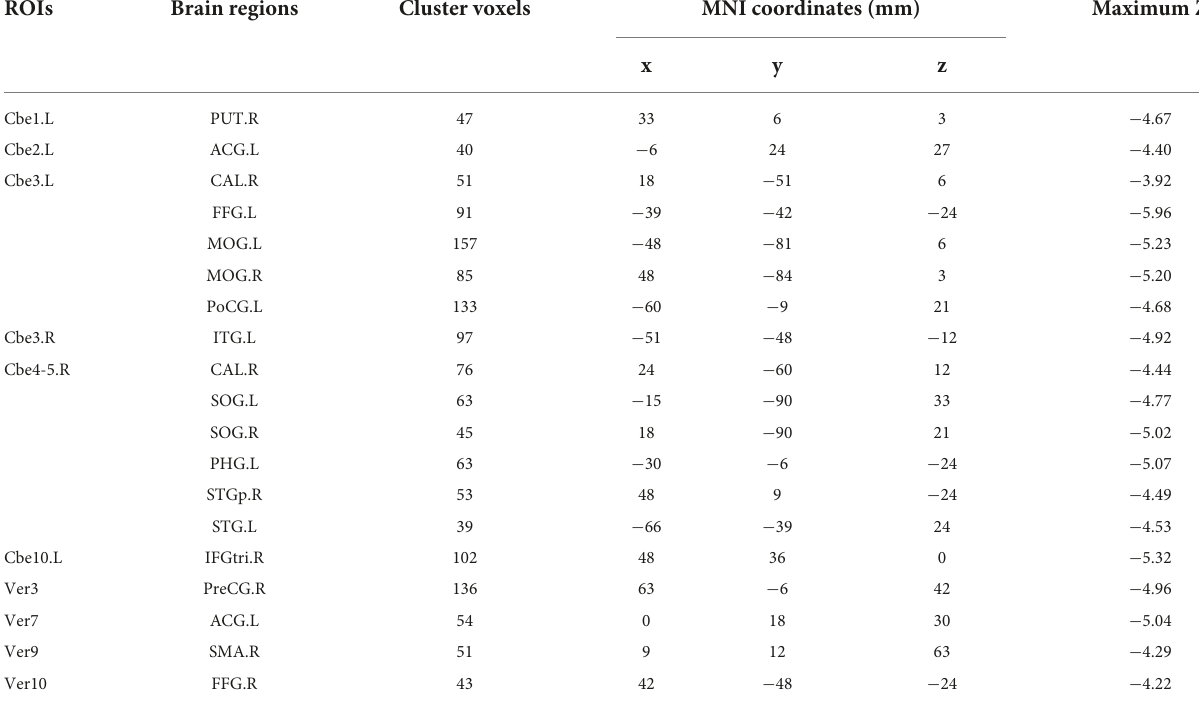
TABLE 2 Regions of significant different connectivity between complete thoracolumbar spinal cord injury (CTSCI) patients and healthy controls (HCs). ROIs Brain regions Cluster voxels MNI coordinates (mm) Maximum Z x PUT.R